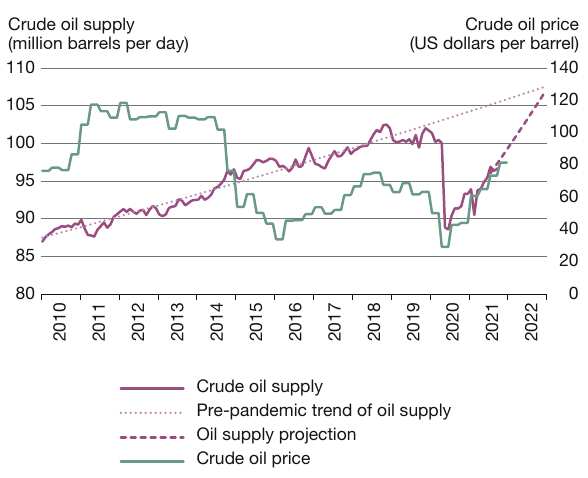
Crude oil price and crude oil